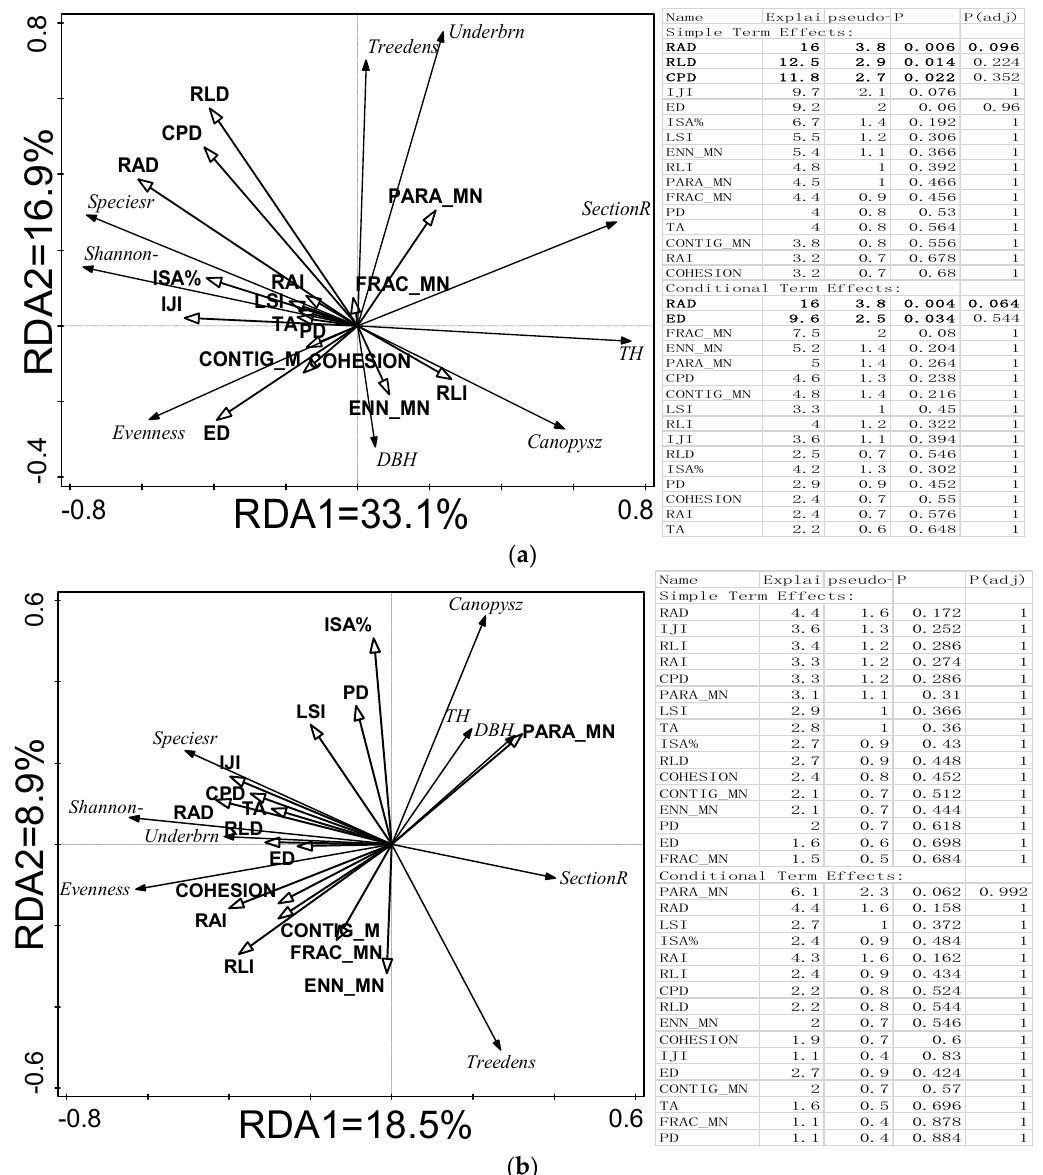
Figure 8. RDA ordination on forest structural-taxonomic attributes from landscape metrics and road characteristics in different road density (RD) regions. ( a ) low RD region and ( b ) medium and heavy RD regions. RD